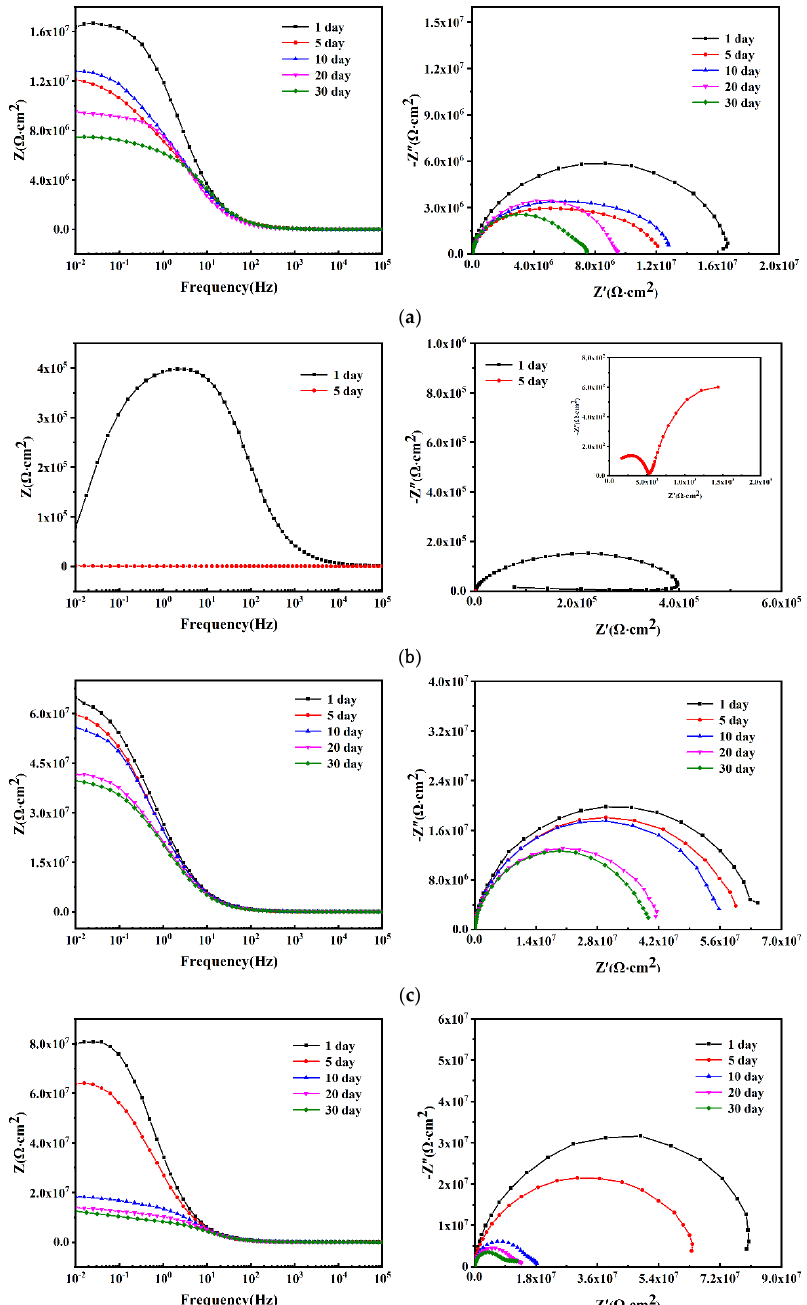
Figure 10. Nyquist and Bode plots of the specimens with different coatings. ( a ) Pure WPU, ( b ) 0.5 wt.% GO/WPU, ( c ) 0.5 wt.% PVSQ-GO/WPU, and ( d ) 1.0 wt.% PVSQ-GO/WPU.